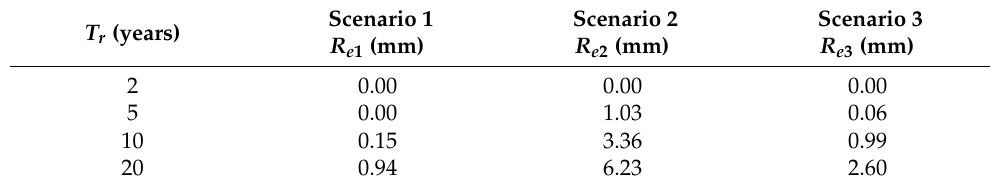
Table 4. Effective rainfall ( R e ) corresponding to the concentration-time ( t c ) for different return periods ( T r ).